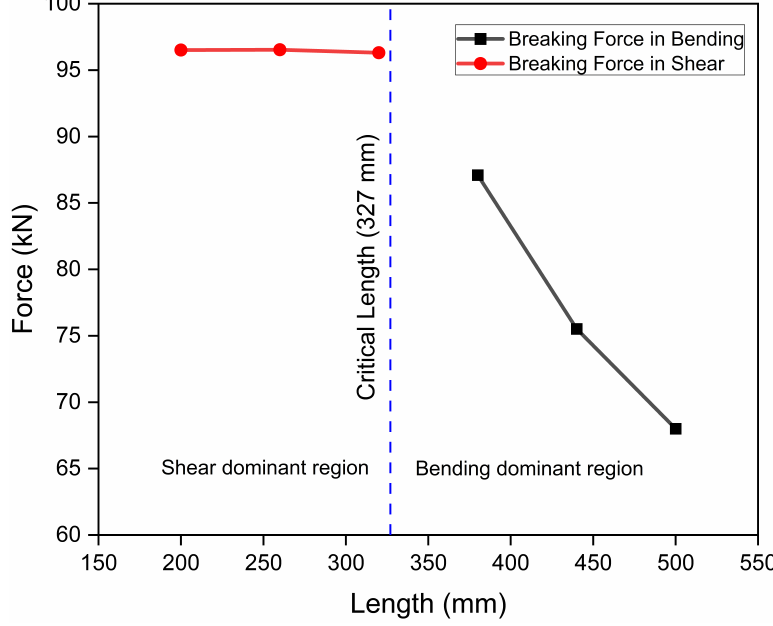
Figure 8. Effect of length on break force in shear and bending